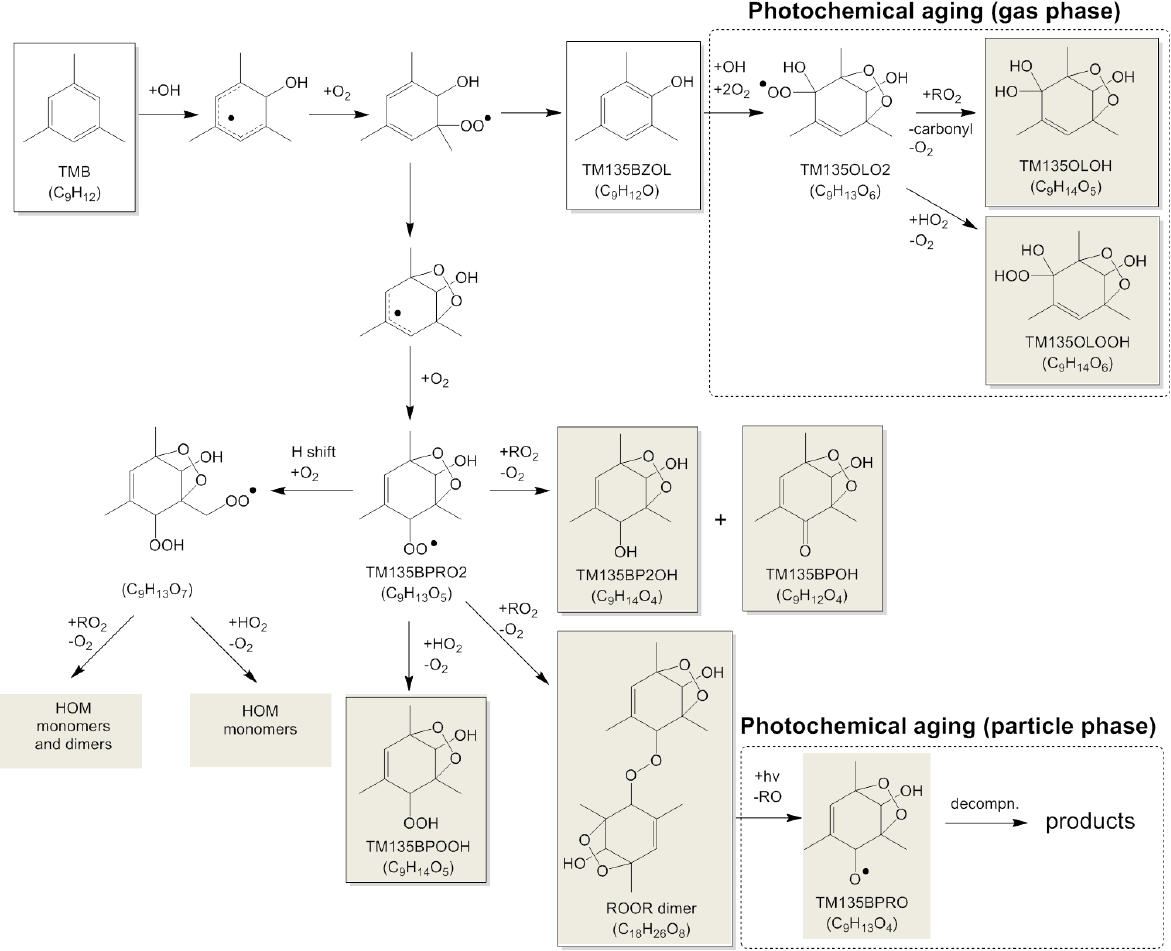
Figure 5. Suggested mechanism for the formation and photochemical aging of abundant products. Shaded products may exist predominantly in the particle